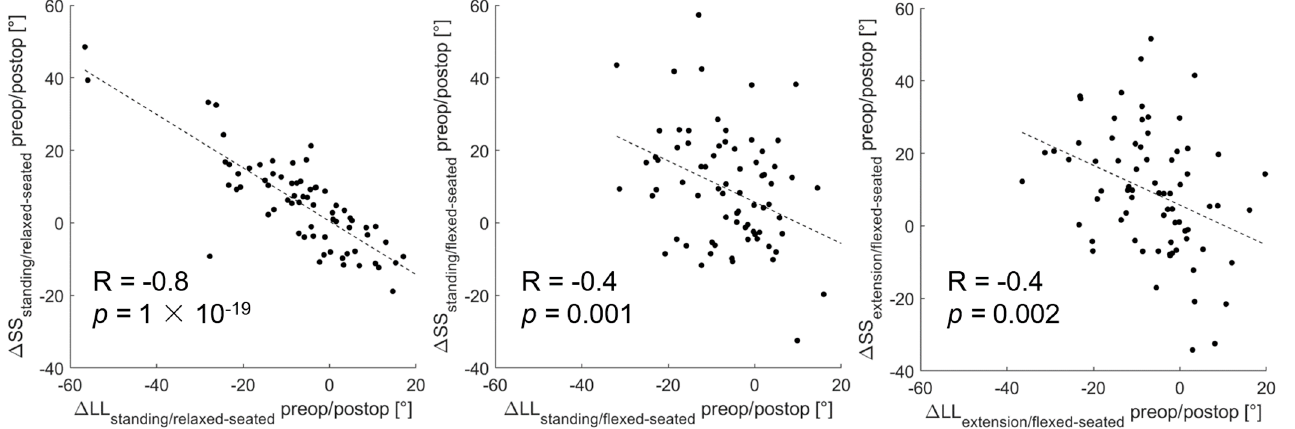
Figure 4. Correlation between the change of Δ LL and Δ SS between preoperative and 12 months postoperative form standing or extension to relaxed- or flexed-seated position.